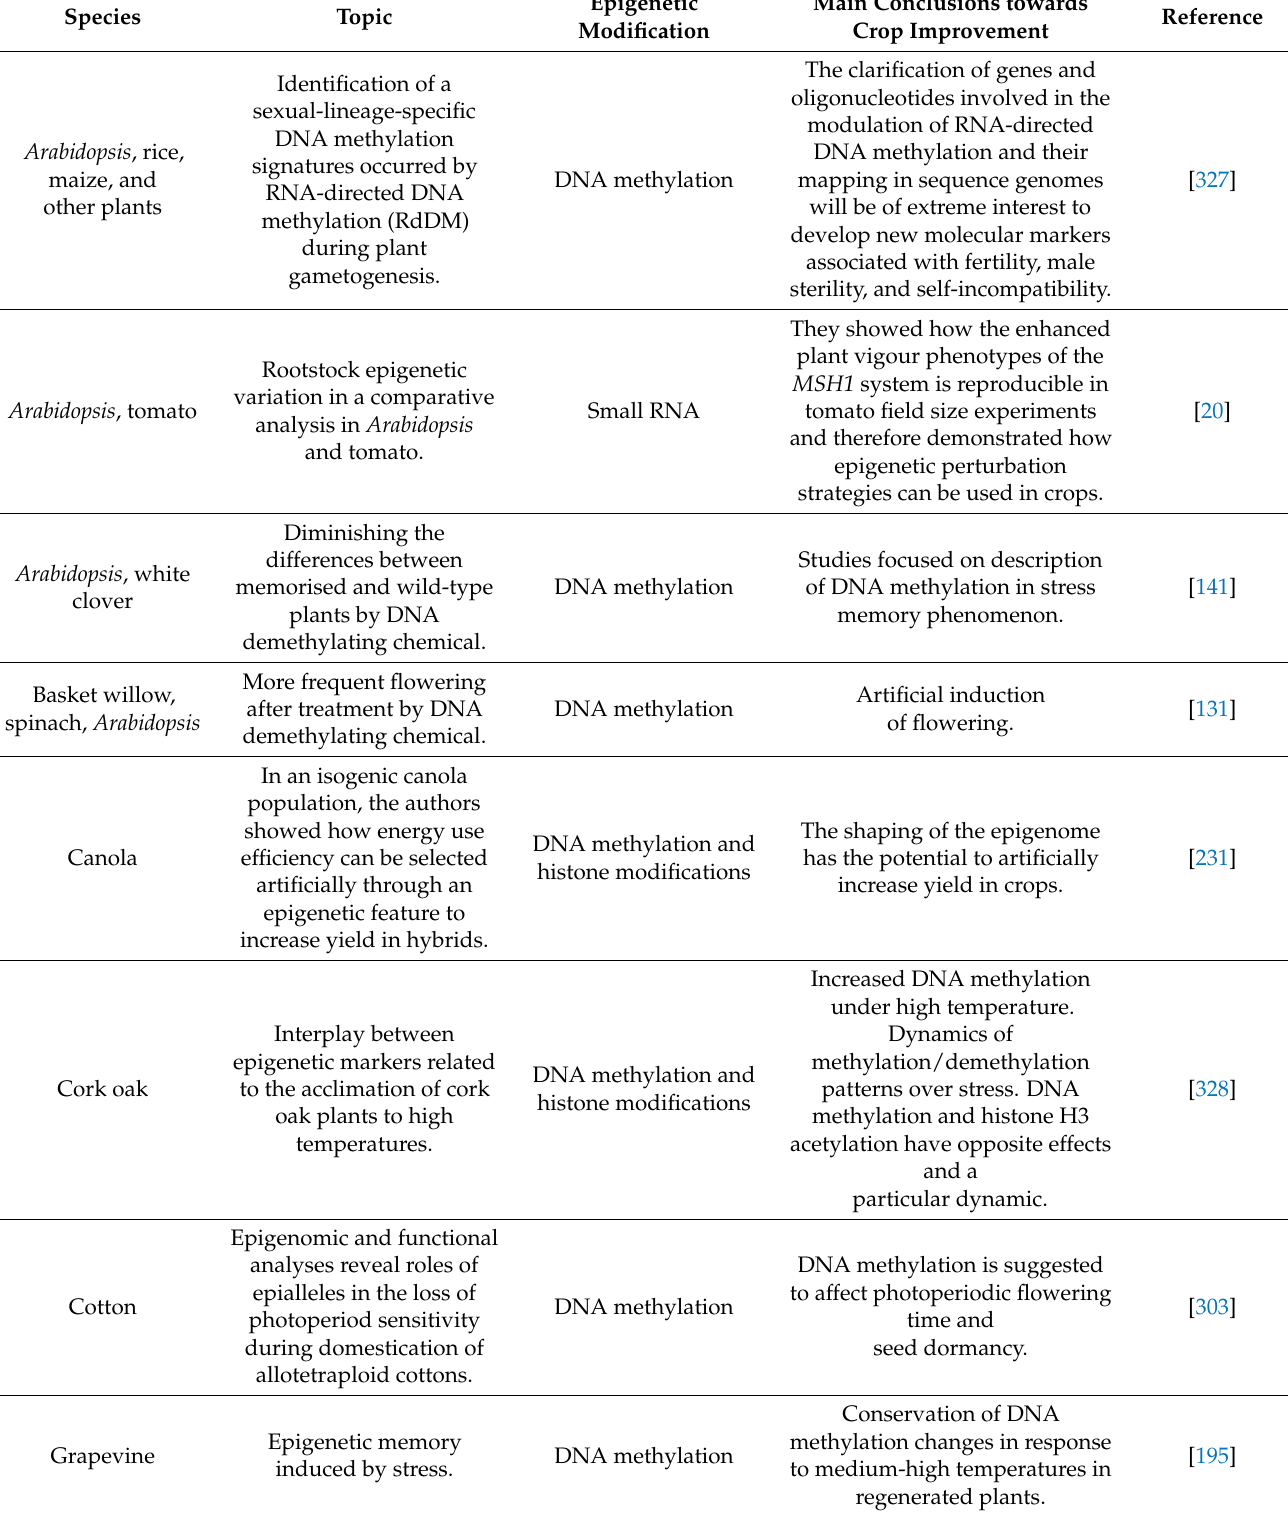
Table 1. Examples of epigenetics for crop